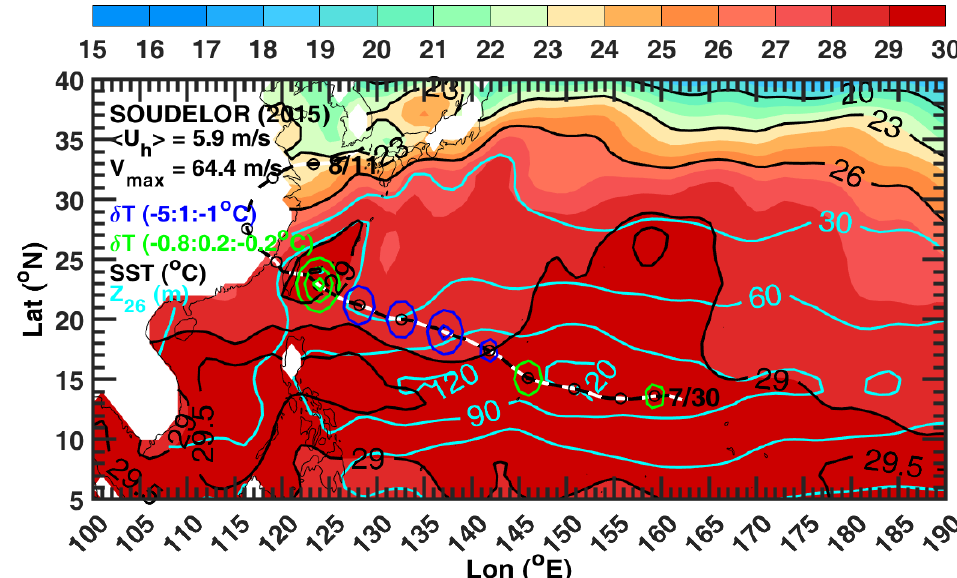
Figure 2. SST (shading and black contours, °C) and Z 26 (cyan contours, m) from the EN4.2.2 analysis [20] during Typhoon Soudelor (30 July–11 August 2015; track: dashed line with circles). The display (top left) shows Soudelor’s averaged <U h > and lifetime maximum wind V max . Modelled SST cooling is shown as green or blue contours, following a Gaussian distribution around each daily track point with the peak = δ T from (10); green is δ T < 1 °C (interval = 0.2), and blue is δ T ≥ 1 °C (interval = 1), see display.